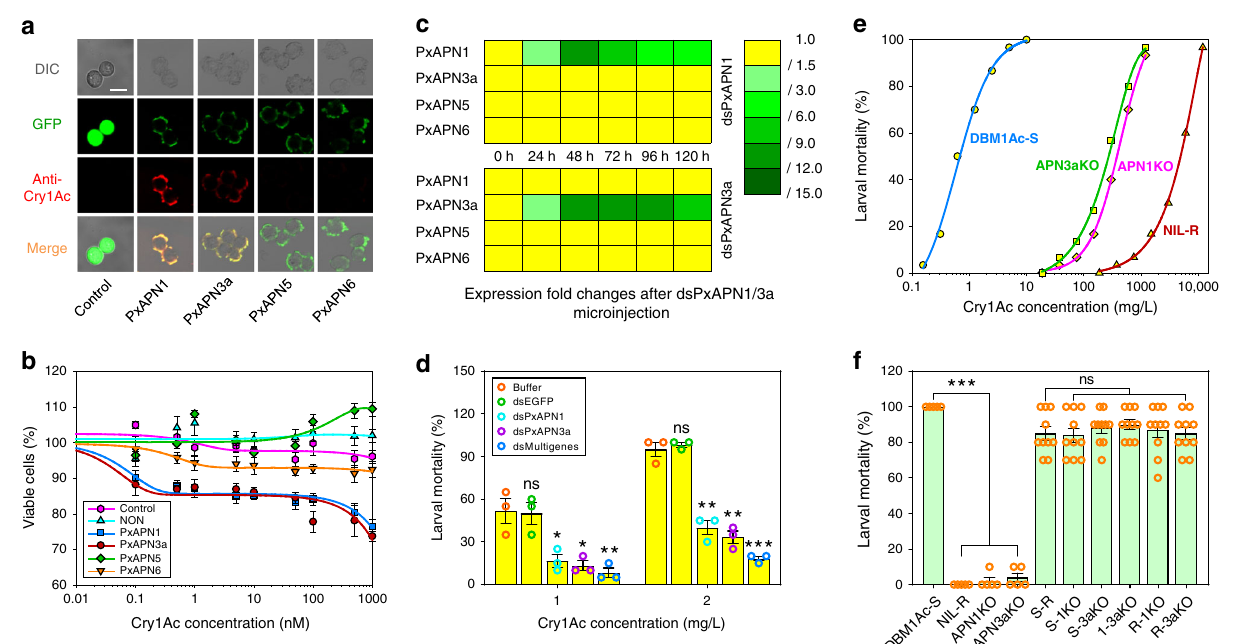
Fig. 2 PxAPN1 and PxAPN3a are functional Cry1Ac receptors in P. xylostella . a Detection of Cry1Ac binding to Sf9 cells expressing PxAPN proteins by immunolocalization. Gray panels: differential interference contrast (DIC) microscopy views; green panels: GFP-expression fl uorescent signal; red panels: Cry1Ac-binding fl uorescent signal. Mixed color panels: merged images from both the green and red fl uorescent channels. The scale bar is 20 μ m. b Susceptibility to a series of concentrations of Cry1Ac toxin (0.1 nM to 1 µ M) in untransfected Sf9 cells (control), Sf9 cells transfected with only an empty expression vector (NON) and PxAPN-expressing Sf9 cells after 24 h incubation. c RNAi-mediated silencing of PxAPN1 or PxAPN3a is expressed relative to transcript level for each gene at time 0 h, which are displayed as expression fold changes and color-coded according to the gradient. d Susceptibility to Cry1Ac protoxin in DBM1Ac-S larvae injected with buffer or dsEGFP, dsPxAPN1, dsPxAPN3a or a multiple gene mixture (dsPxAPN1 and dsPxAPN3a). e Non-linear log dose – response curves for P. xylostella larvae from the susceptible DBM1Ac-S strain, the CRISPR/Cas9-mediated PxAPN1 and PxAPN3a knockout strains PxAPN1KO and PxAPN3aKO, and the near-isogenic resistant strain NIL-R exposed to Cry1Ac protoxin. f Interstrain allelic complementation tests with diagnostic doses of Cry1Ac protoxin (10 mg/L). F1 progeny were produced by crossing one susceptible and three resistant strains in all pair-wise combinations. Data are presented as mean values ( c ) and mean values ± SEM ( b , d , f ), n = 6 ( b , c ), n = 3 ( d ), and n =